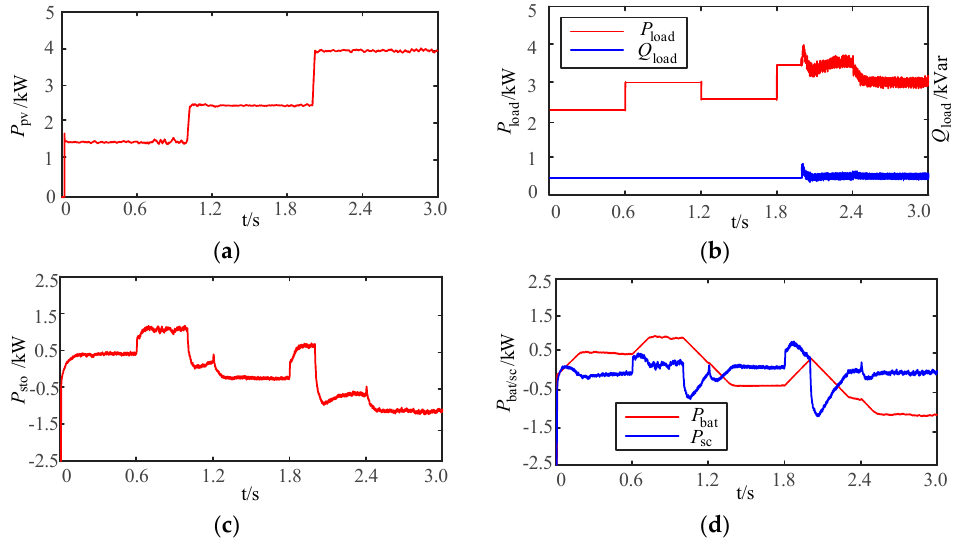
Figure 10. Simulation results of energy router in case 1: ( a ) PV generation; ( b ) Load consumptions; ( c ) Total charging or discharging power of the self-energy storage system; ( d ) Charging or discharging power of the battery and supercapacitor.